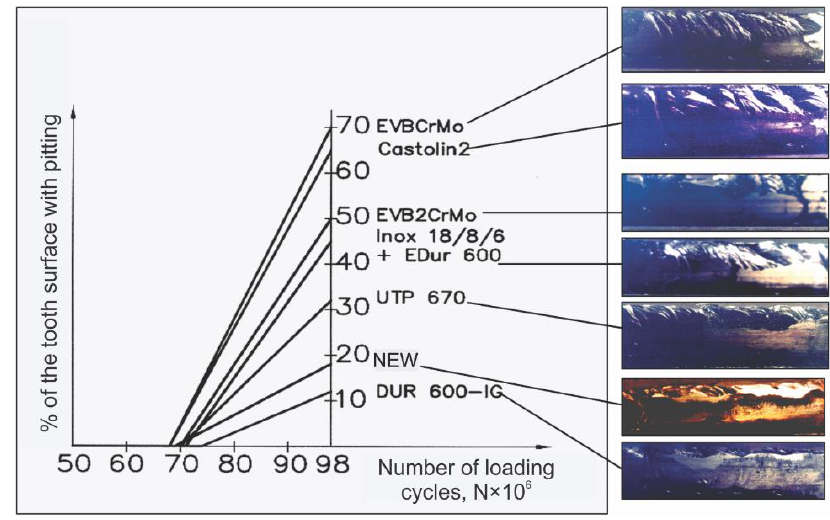
Figure 19. The development rate of the destructive pitting on the teeth flanks.